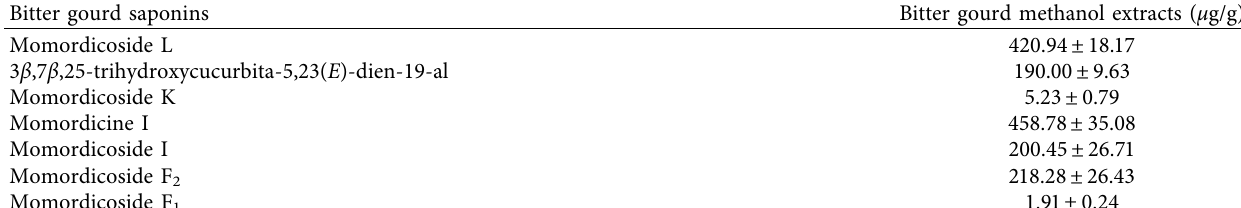
Table 3: Contents of specific bitter gourd saponins in bitter gourd